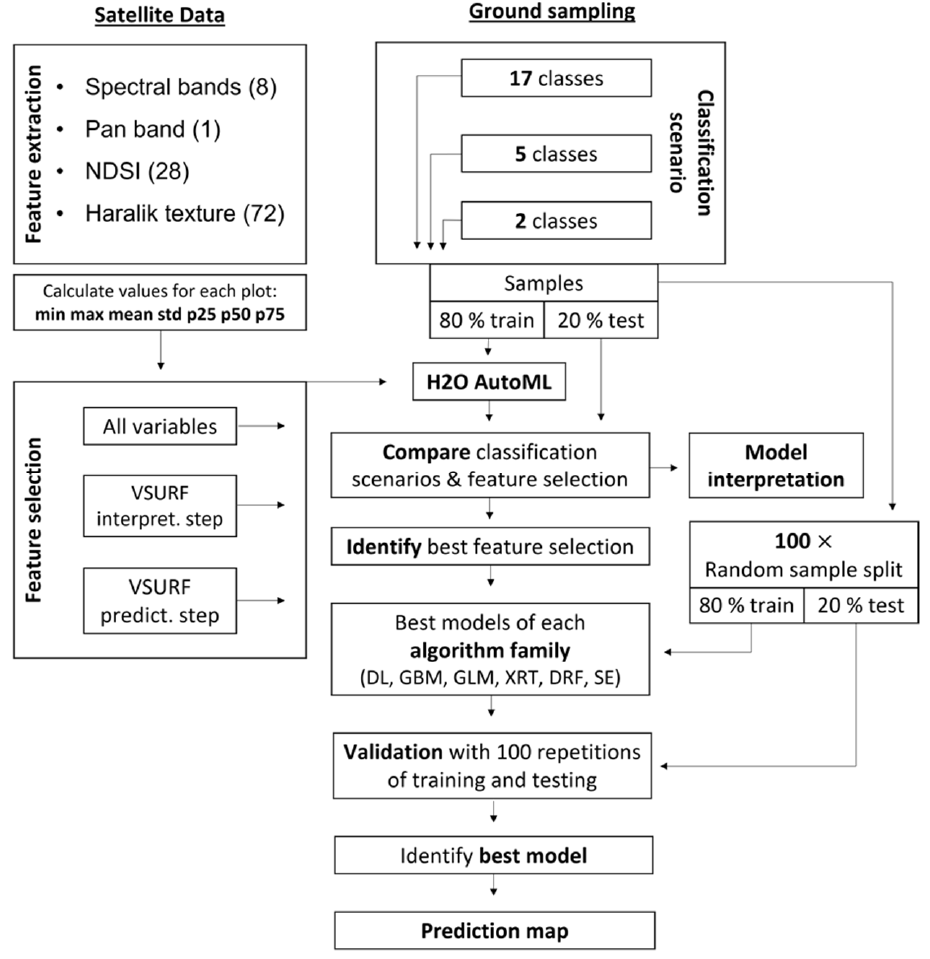
Figure 3. Scheme of model development. DL: Deep Learning, GBM: Gradient Boosting Machine, GLM: Generalised Linear Model, XRT: Extremely Randomized Trees, DRF: Distributed Random Forest, SE: Stacken Ensembles.